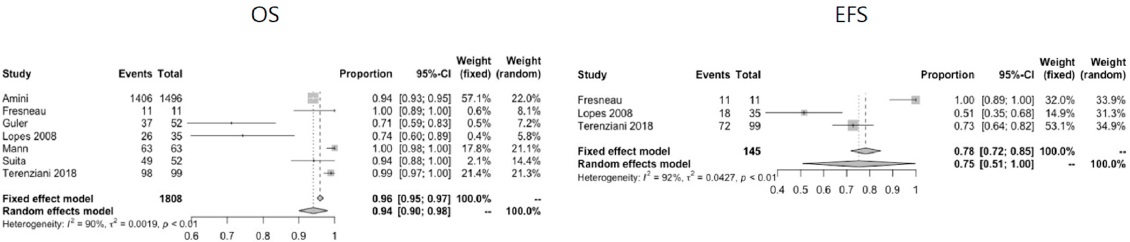
Figure 4. Pooled OS and EFS data for testicular GCTs.